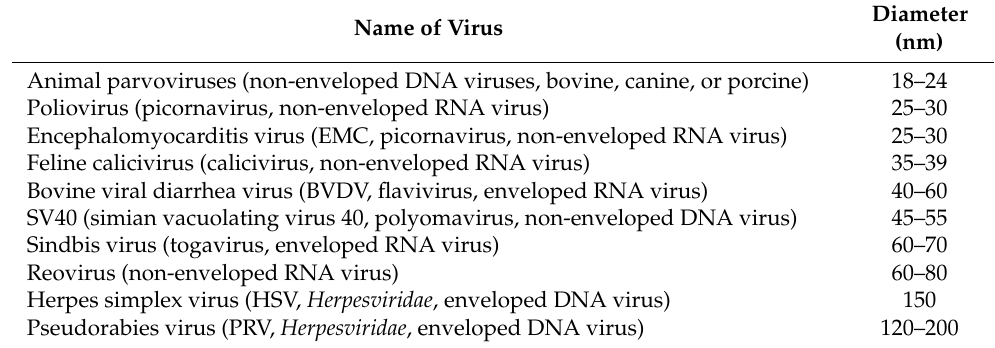
Table 2. Some common viruses used for validation studies in biomanufacturing [21]. Name of Virus